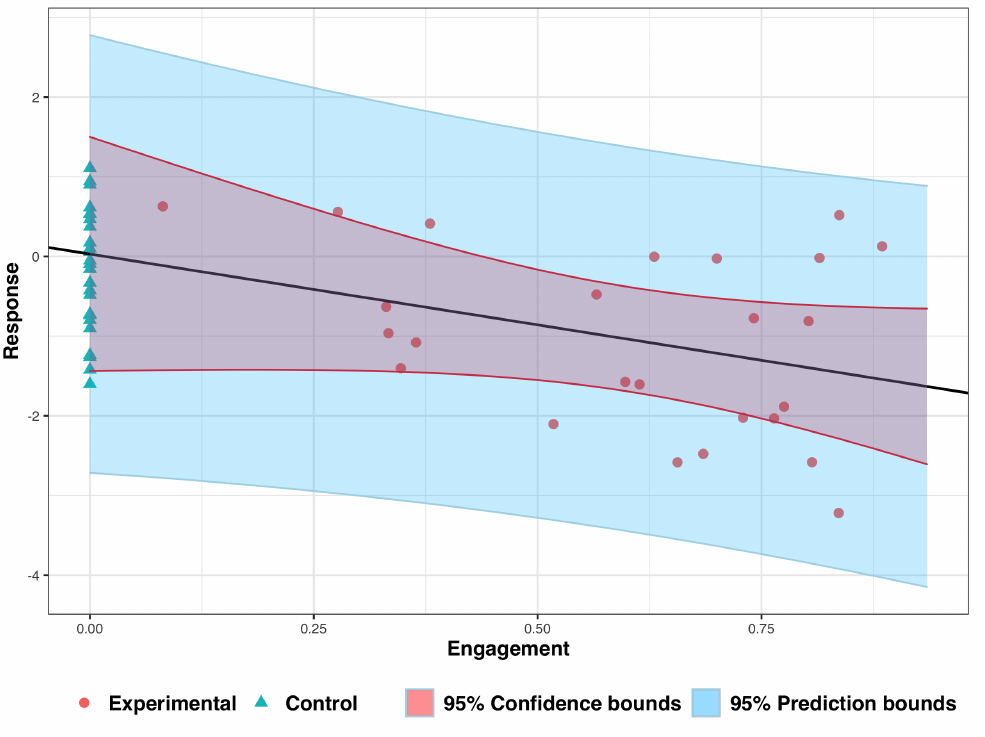
Figure 1. An example of experimental data from a trial of n = 50 subjects (25 per group). Group 1 (ex- perimental) observations are red circles; group 2 (control) observations are green triangles. ANCOVA- fitted linear regression (solid black line) is (cid:98) µ E + (cid:98) γ x